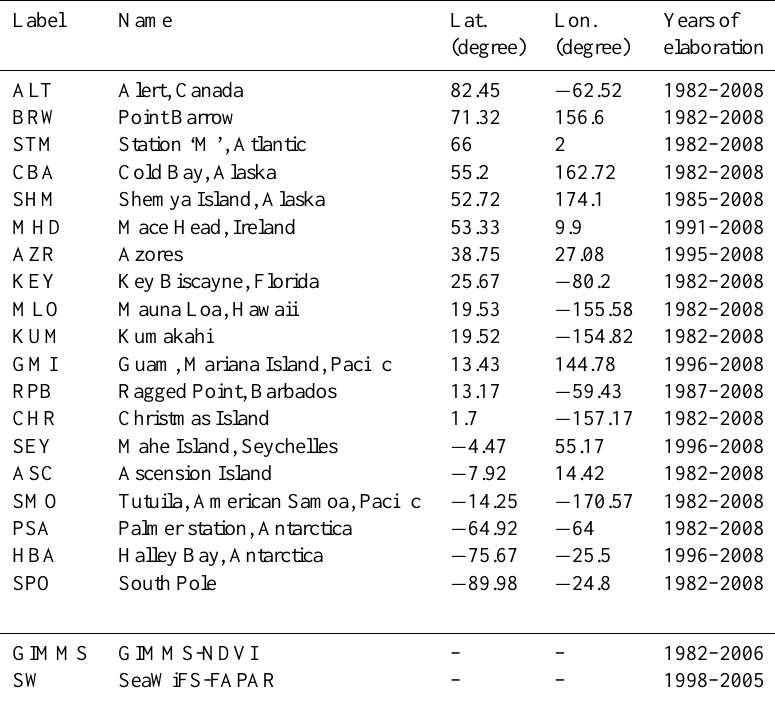
Table 1. List of selected atmospheric CO 2 monitoring stations and satellite-based vegetation activity datasets used in the analyses, as well as the time period used for elaborations. Label Name Lat.